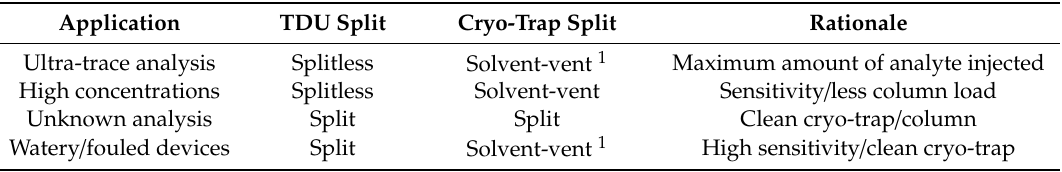
Table 1. Common parameters of two-stage thermal desorption and their